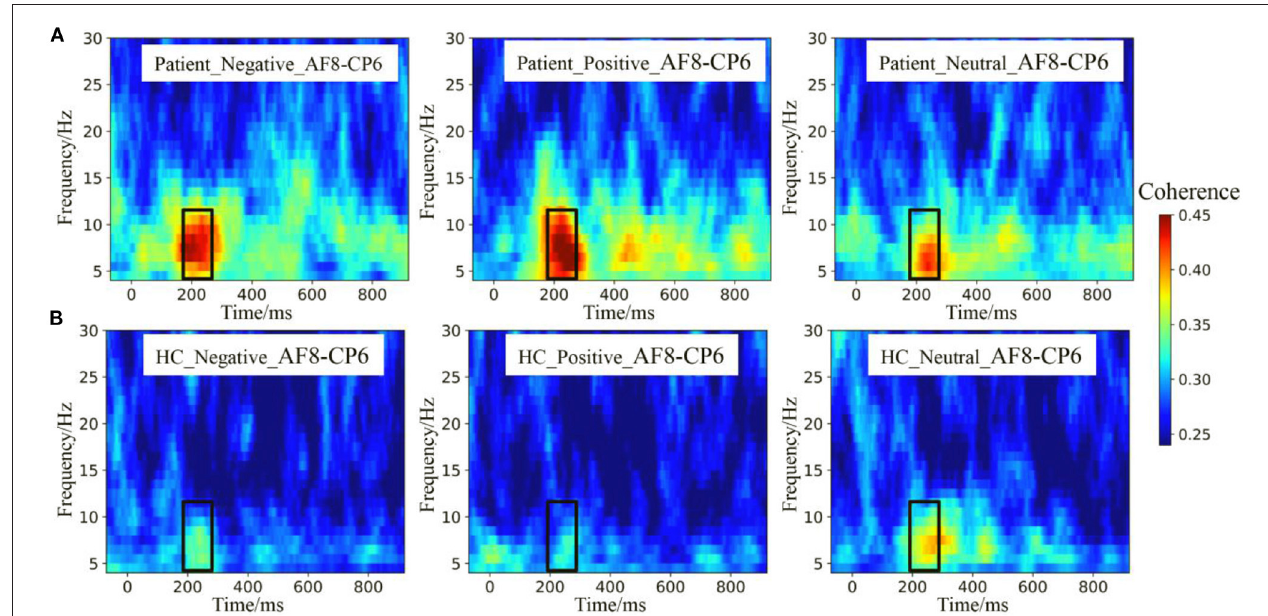
FIGURE 4 | Event-related phase coherence (ERPCoh) between the frontal and parietal electrodes. (A) The theta and alpha band ERPCoh from the AF896CP6 electrode pairs in patients. (B) The theta and alpha band ERPCoh from the AF896CP6 electrode pairs in HCs.